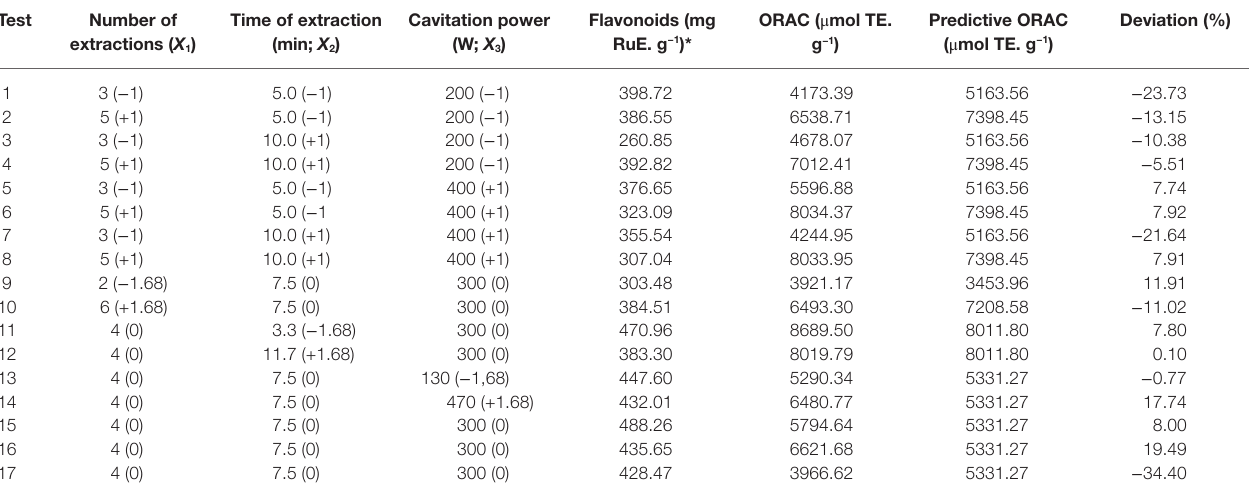
Test Number of extractions ( X 1 )